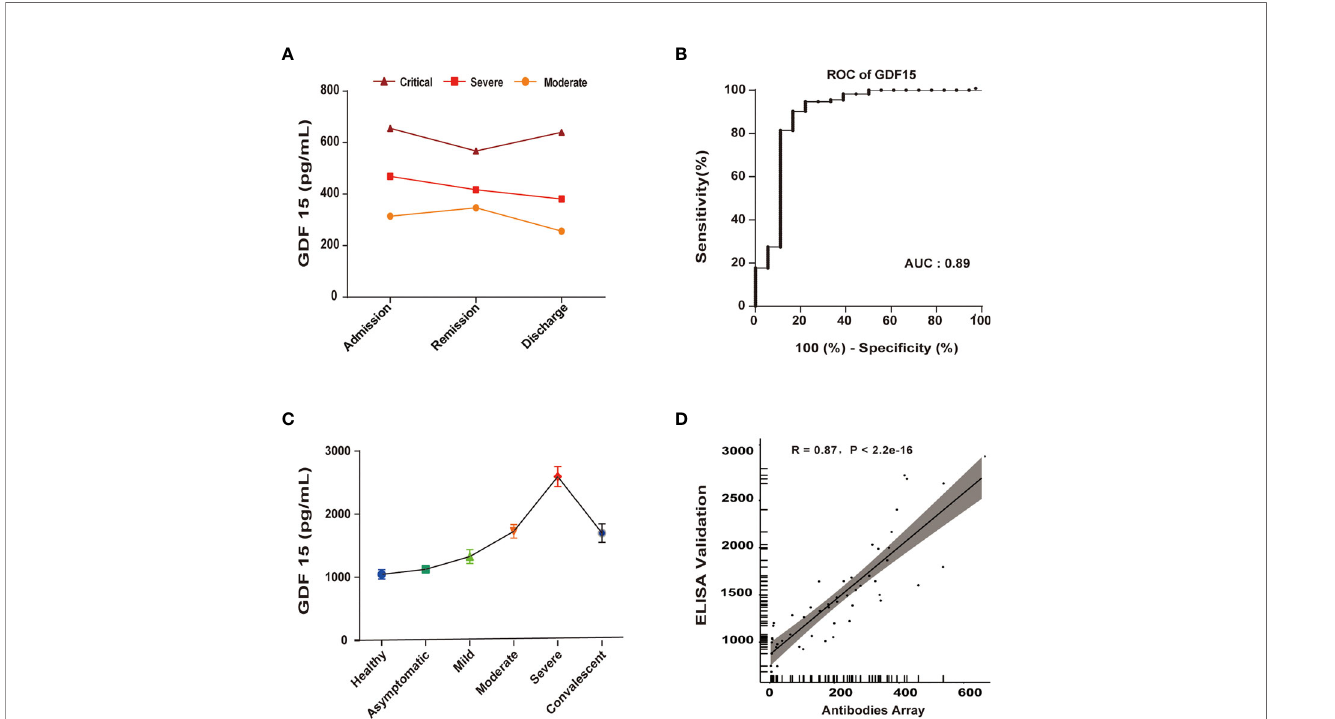
FIGURE 4 | GDF15 is an independent predictor of the progression of COVID-19. (A) GDF15 levels in critical (n=1), severe (n=4), and moderate (n=10) groups, each as a function of the progress of the infection/patient status. (B) The AUC value of 0.89 indicated the serum GDF15 level to be an ef fi cient diagnostic indicator of disease severity in COVID-19 patients. (C) ELISA-determined GDF15 level as a function of disease severity. (D) ELISA-determined GDF15 levels compared to antibody array-determined levels showed a strong correlation (R = 0.87, P < 2.2e −